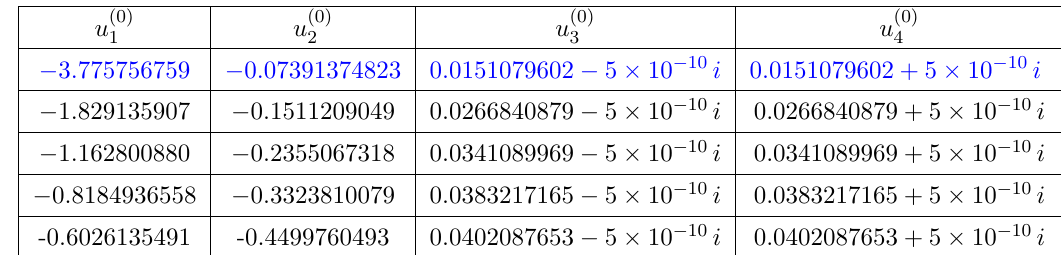
u (0) ; u (0) ; u (0) ; u (0) corresponding to 1 2 3 4 g f 2 ; 4 ; 2 . We only present them with f g we need to go up to 10 (cid:0) 35 2